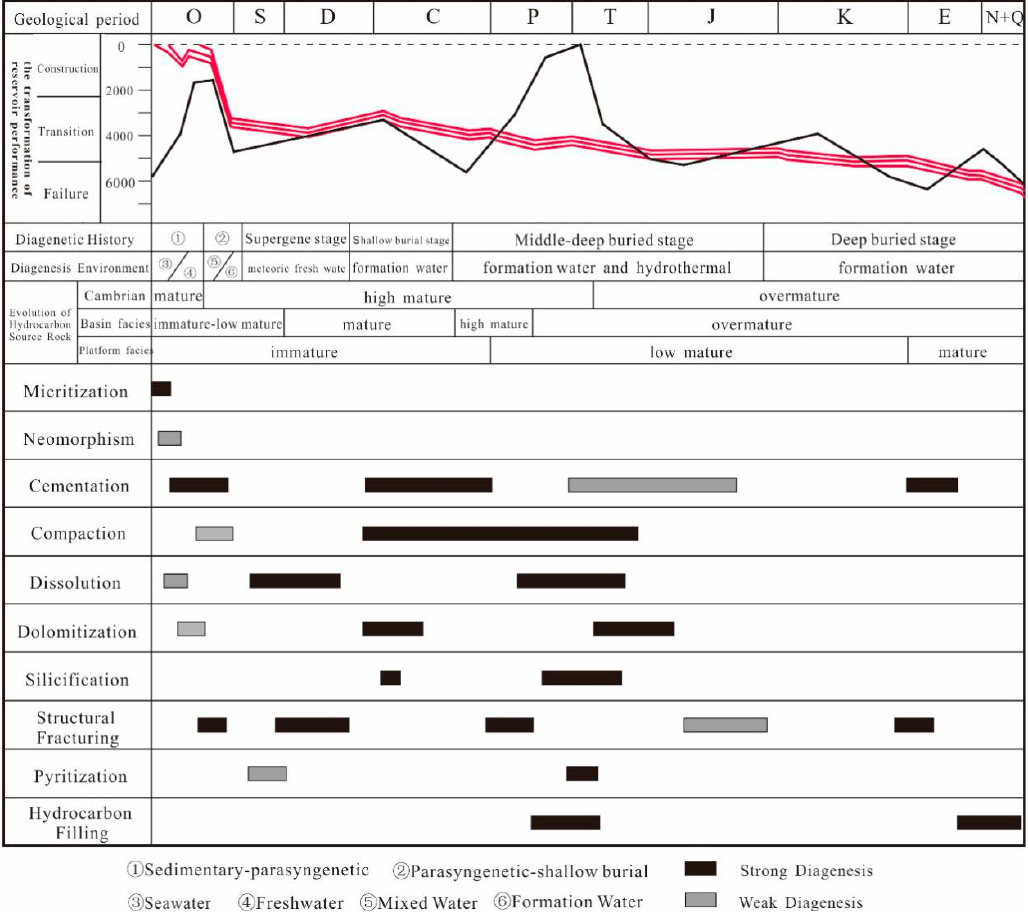
Figure 3. Diagenetic evolution of the Middle ‐ Lower Ordovician carbonate.